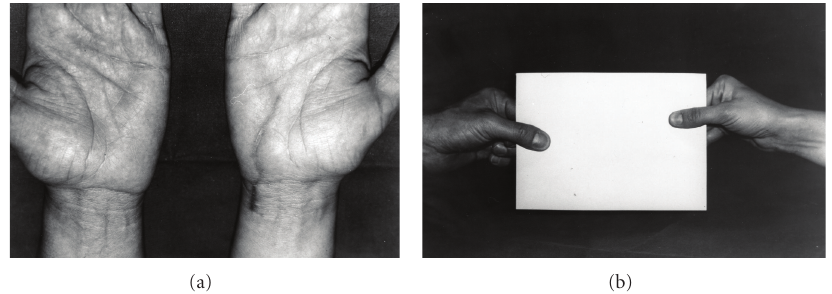
Figure 2: The surgical scar eight months after surgery (a), when Froment’s sign became negative (b).